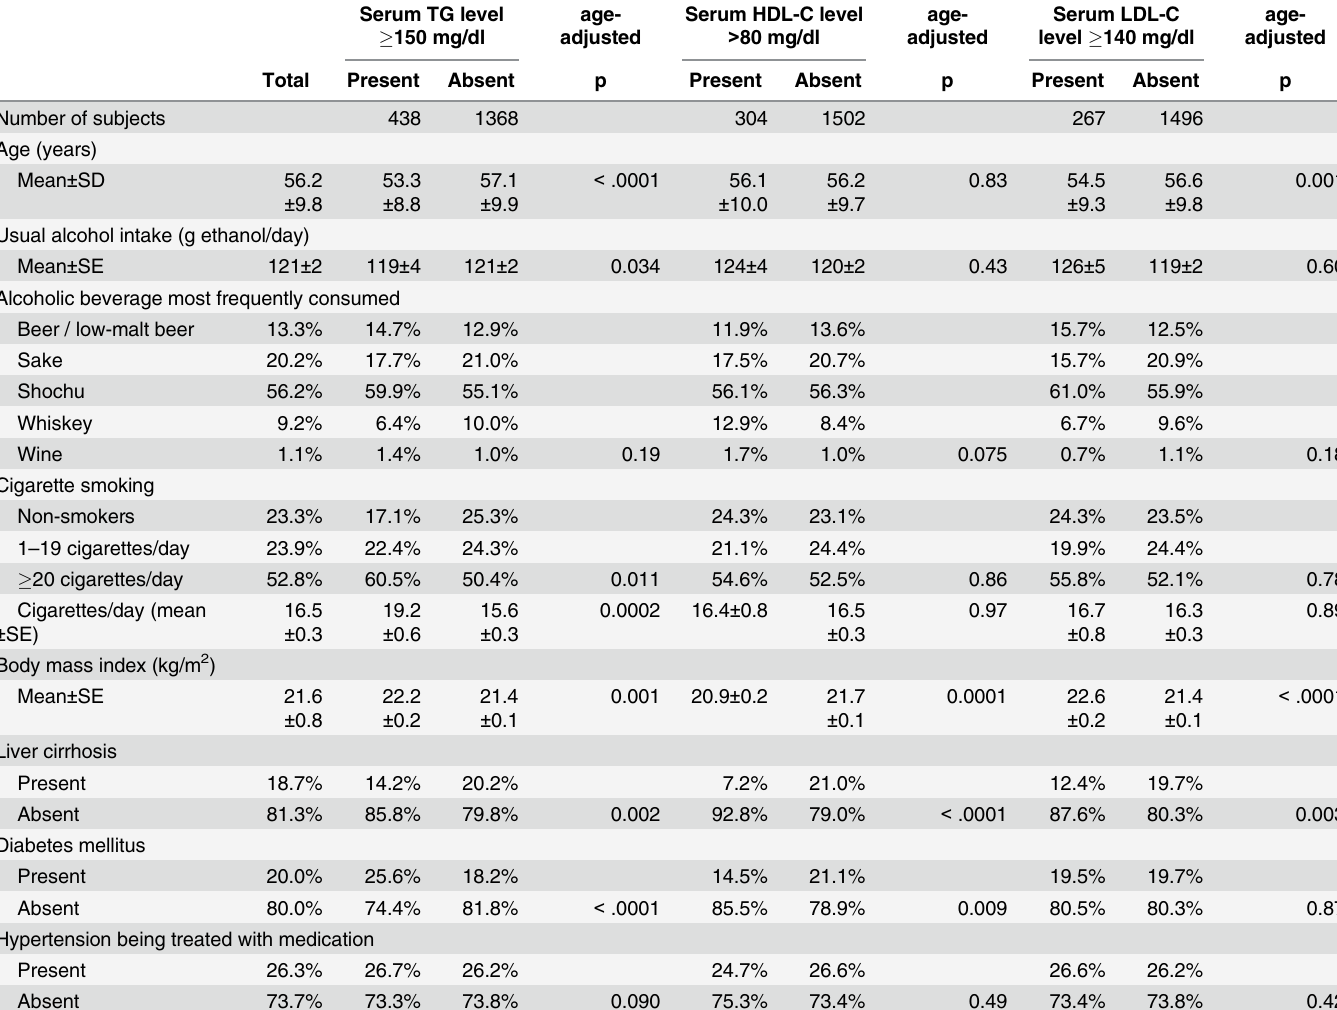
Table 1. Background of Japanese alcoholic men according to whether they had abnormal serum lipid